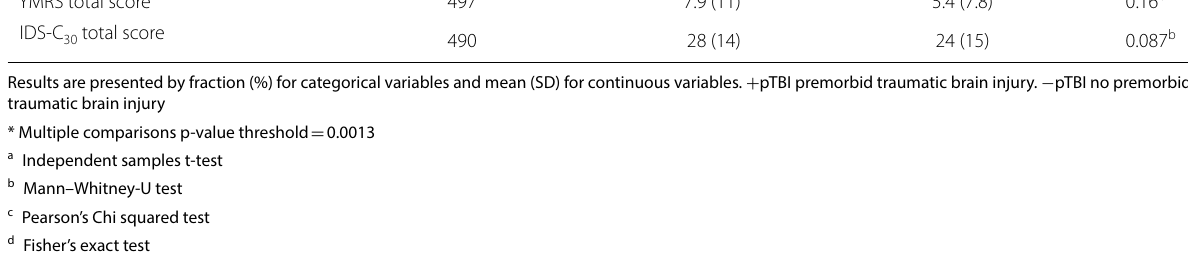
Table 4 Final step of the backward likelihood ratio logistic regression analysis on variables independently associated with premorbid traumatic brain injury among patients with bipolar disorder